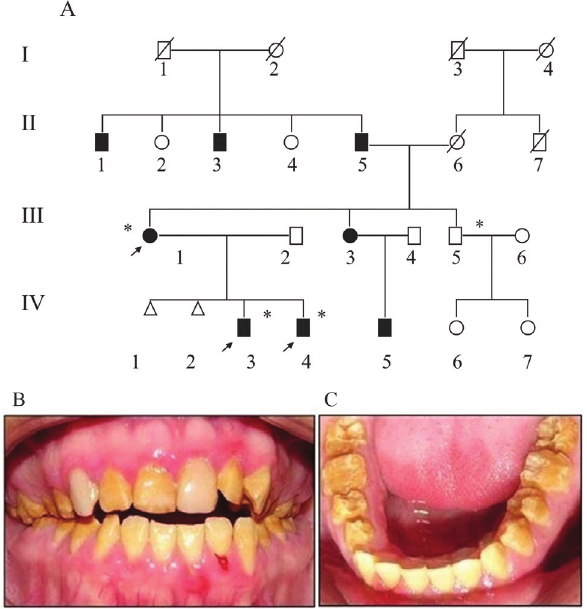
Figure 5 - Family 5. A. The pedigree indicated autosomal dominant inher- itance. The arrows indicate the proband patients and the asterisks indicate individuals who were analyzed clinically and whose ENAM gene was se- quenced. B. Photograph of proband III:7. The AI phenotype in this family was classified as hypocalcified. However, AI was not generalized among membersofthisfamilybutwasrestrictedtohypocalcifiedareas.Thisindi- vidual showed no signs of wear on the occlusal surfaces, probably because of her young